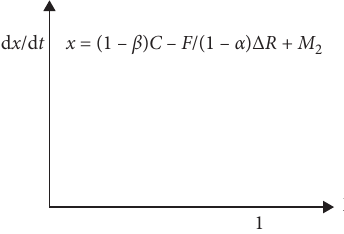
Figure 7: Stable solution for x � (( 1 − β ) C − F / ( 1 − α ) Δ R + M )) . 1